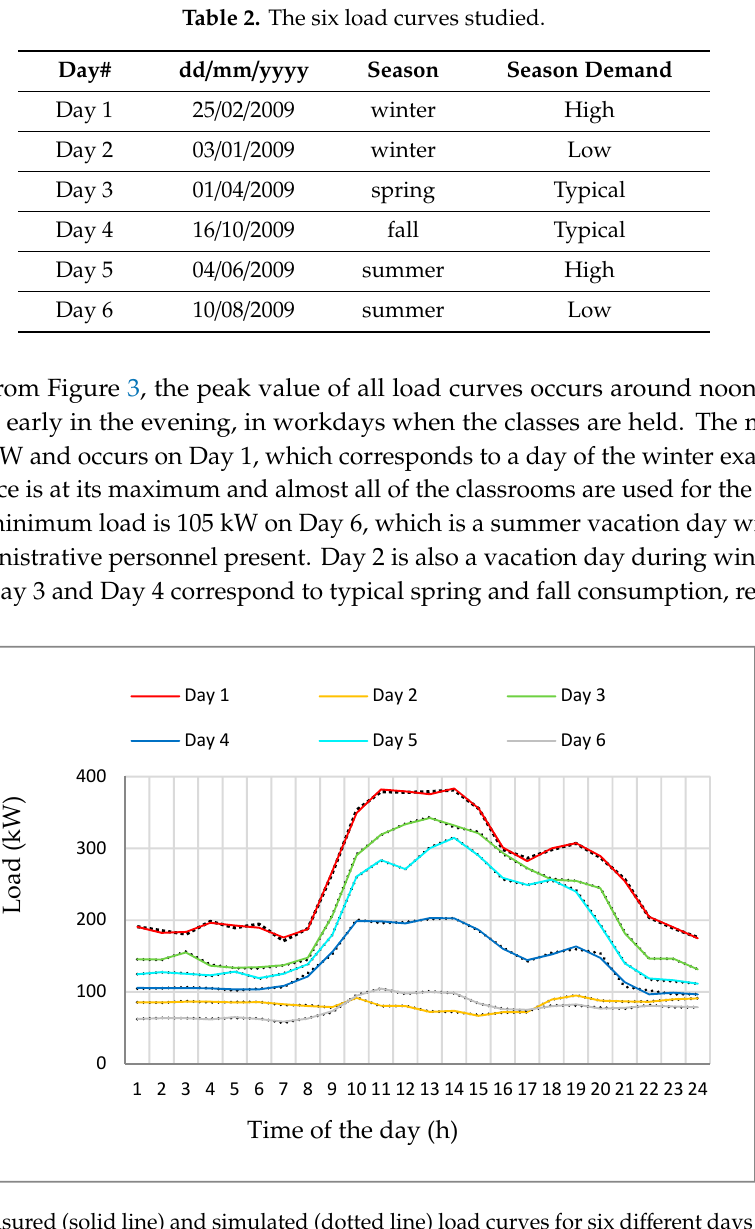
( d ) Figure 4. Data used as input to renewable energy systems (RES) models ( a ) Solar irradiance, in W/m 2 ; ( b ) Temperature, in °C; ( c ) Wind velocity, in m/s; and, ( d ) Tidal current velocity, in m/s.